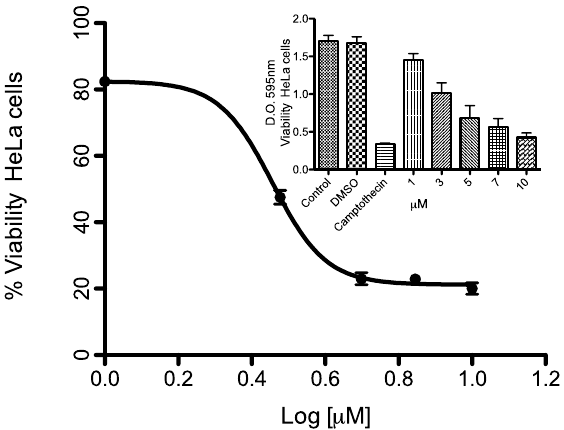
Figure 3. Cytotoxicity of 2-(4-hydroxy-3-methoxyphenyl)-benzothiazole on HeLa cell line. After 48 h of exposure, an MTT assay was performed and IC 50 = 2.86 μM was calculated. Camptothecin 1 μM was used as a positive